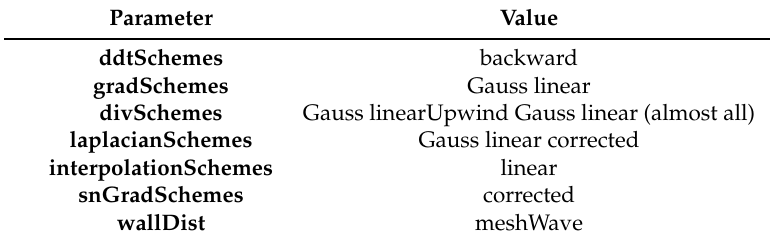
Table 2. fvSchemes setting will affect calculation accuracy and computational stability.